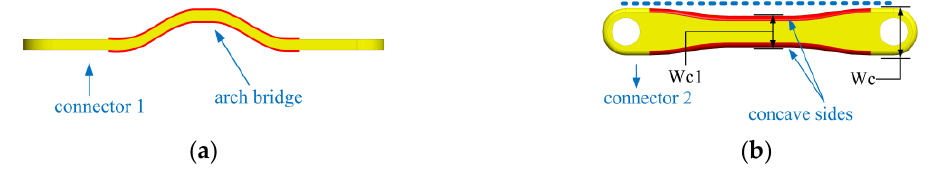
Figure 2. The detailed view of feeding connectors: ( a ) connector 1 in side view and ( b ) connector 2 in top view.